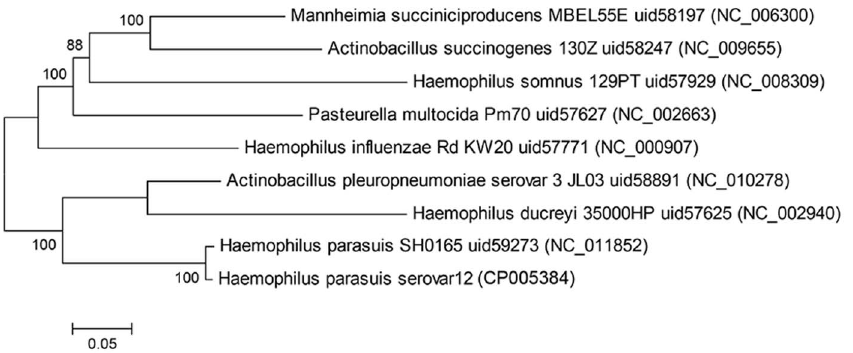
Figure 3. Bayesian phylogenetic tree of H.parasuis strain ZJ0906 and other closely related bacteria. Phylogenetic tree was constructed using MrBayes [17] using the random concatenation of 26 aligned core genes as the dataset and GTR + G + I as the substitution model. The chain length was set to 10,000,000 (1 sample/1000 generations) whilst the burn-in was set as 2000. Posterior probabilities are denoted at nodes.